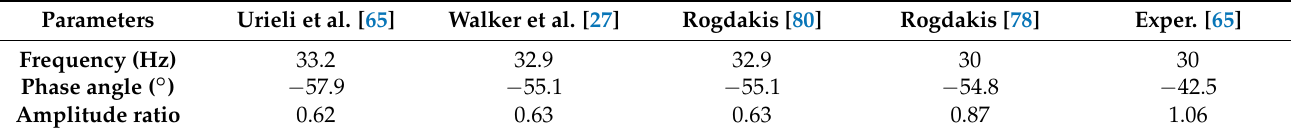
Table 2. Comparison of the stable operation parameters of the RE-1000 obtained by several models. Parameters Urieli et al.